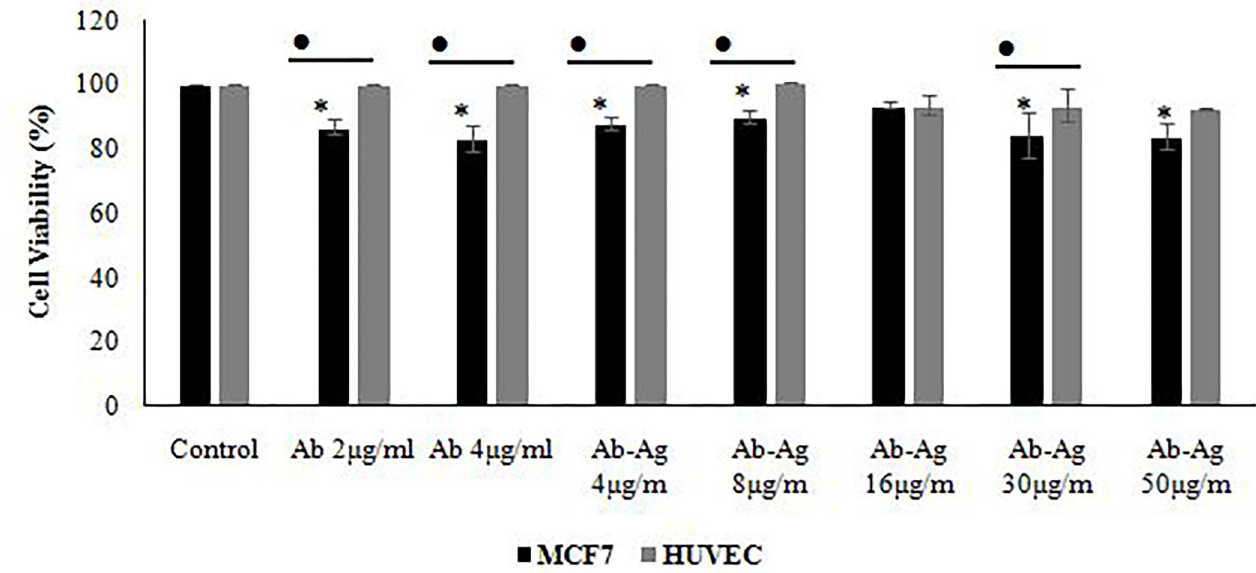
Fig 5. Viability of the MCF7 and HUVEC cell lines after treatment with antibody and antibody conjugated to E . coli antigens using MTT test. The significant differences in the treatment compared to control group and MCF7 compared to HUVEC were shown by using asterisks ( � ) and the bullet (•), respectively (p < 0.05).